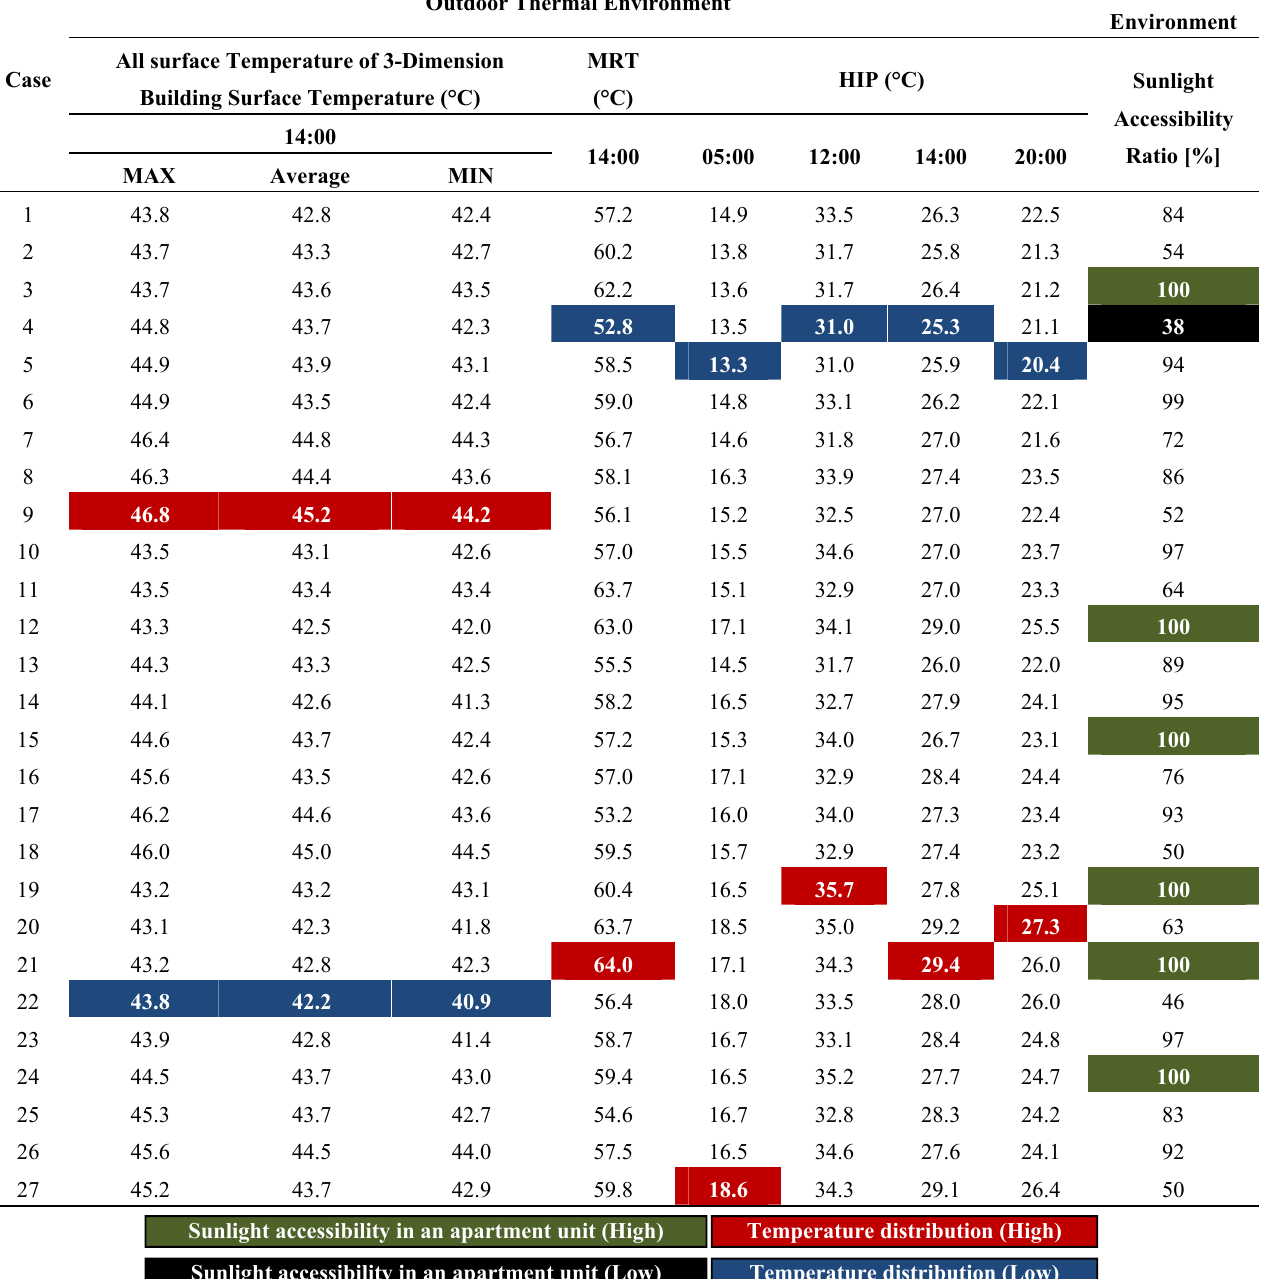
Table 4. Results of outdoor thermal environment and daylight availability